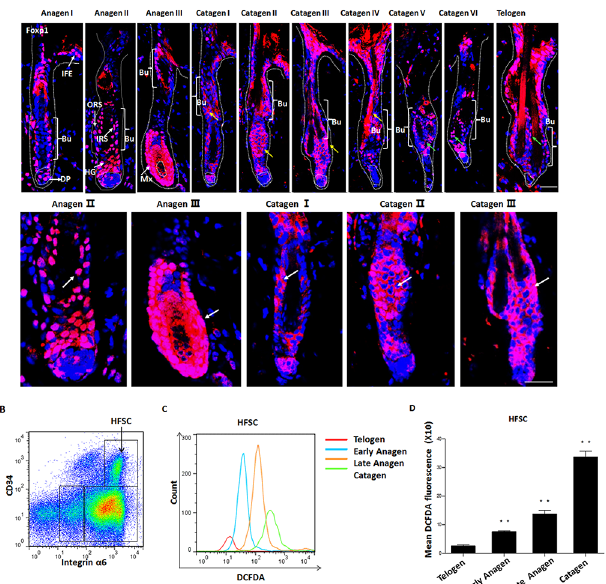
Fig 1. Foxp1 is translocated from the nucleus to cytoplasm of HFSCs at phases from anagen to catagen accompanying with rise of ROS levels. A: Foxp1 distribution among distinct populations of hair follicles. Foxp1 was localized within nuclei from anagen I to III, exported to cytoplasm from catagen I to catagen V, and progressively relocalized into the nuclei at catagen VI and telogen. Lower panel was the high power view of upper panel. Scale bars: 50 μ m. Blue, DAPI; red, anti-Foxp1. Abbreviations: Ep, epidermis; IFE, interfollicular epidermis; Bu, bulge; HG, hair germ; DP, dermal papillae; ORS, outer root sheath; IRS, inner root sheath; HF: hair shaft. B: Representative dot plot of FACS for HFSCs identified by CD34 + /Integrin α 6 + at early telogen (P49). Abbreviations: HFSCs, hair follicle stem cells. C: Histograms of DCFDA fluorescence intensities of HFSCs at telogen (P20), early anagen (P24), late anagen (P27) and catagen (P40) (n = 6, 6, 7, and 6, respectively). D: Quantification of (B) indicates a progressive increase in ROS levels in HFSCs from telogen to catagen. * , p < 0.05; ** , p <